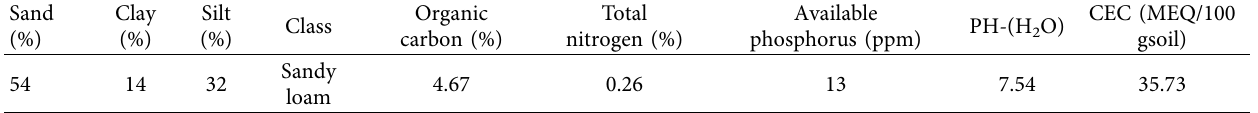
Table 1: Physicochemical characteristics of the experimental